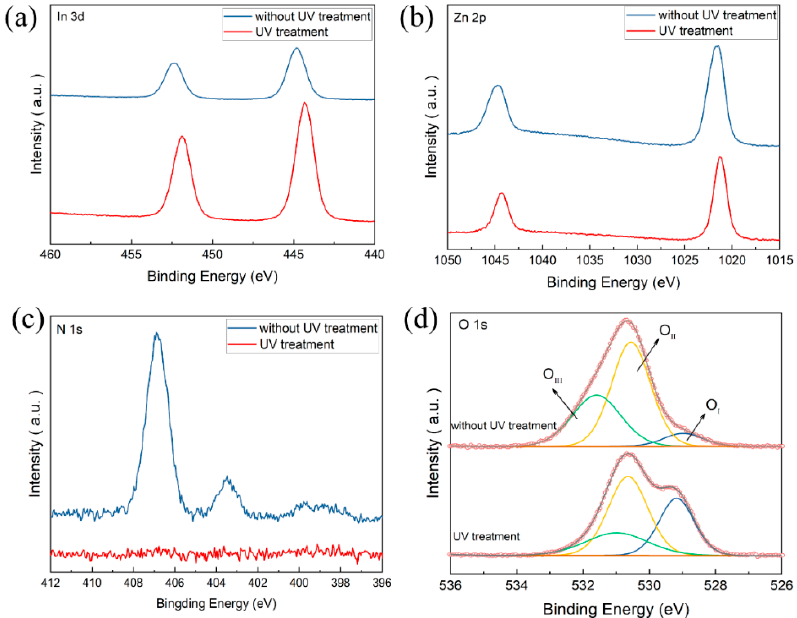
Figure 4. XPS spectra of ( a ) In 3d, ( b ) Zn 3d, ( c) N 1s, and ( d ) O